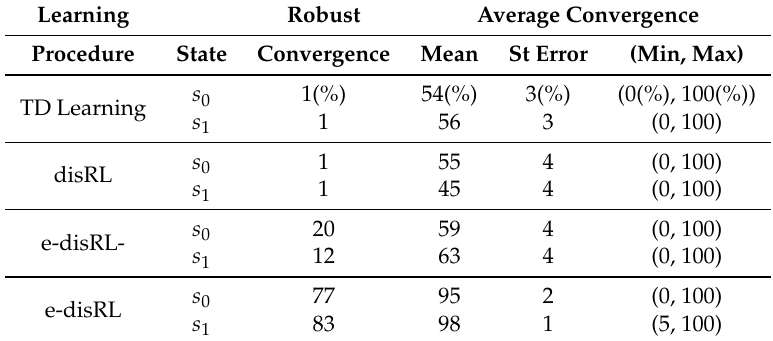
Table 3. Performance in the leptokurtic environment: Details. Robust Convergence: Percentage of 100 game plays the agent reports the optimal policy at the end of all of episodes 11-200; averages across states are reported in Table 2. Average Convergence: Percentage of episodes in a game play where optimal policy is reported at episode end. Episodes 1-10 are excluded. Mean, St Error and Min, Max are calculated over 100 game plays.